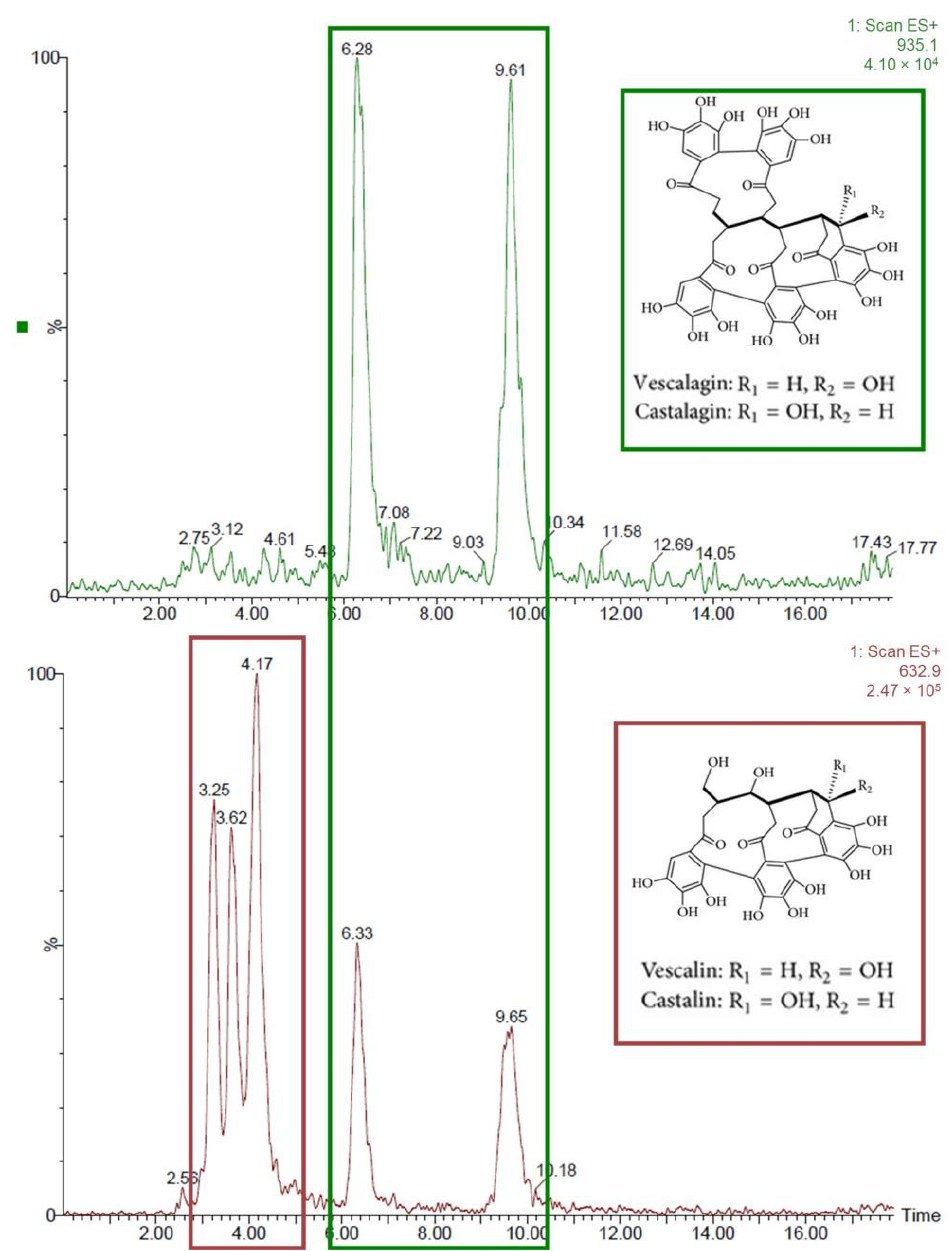
Figure 10. LC-MS analysis, vescalagin/castalagin (m/z: 934.6) and vescalin/castalin (m/z: 632.4) spectra. Masses are selected +0.5 m/z due to detector calibration.